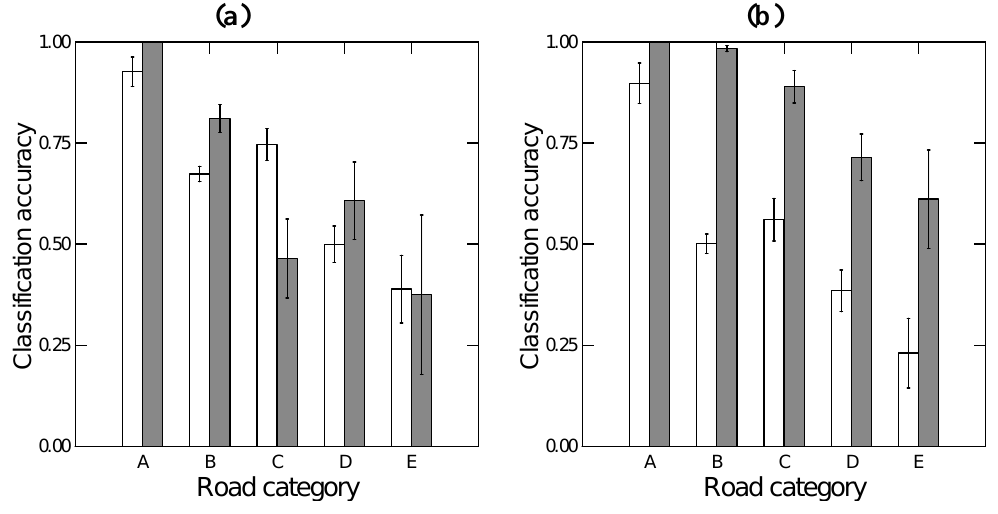
Figure 5. Road classification accuracy (proportion correctly classified and standard error) for: (a) interpreters with (grey bars) and without (white bars) surveying skills; and (b) interpreters with (grey bars) and without (white bars) local knowledge. See Table 2 for road category